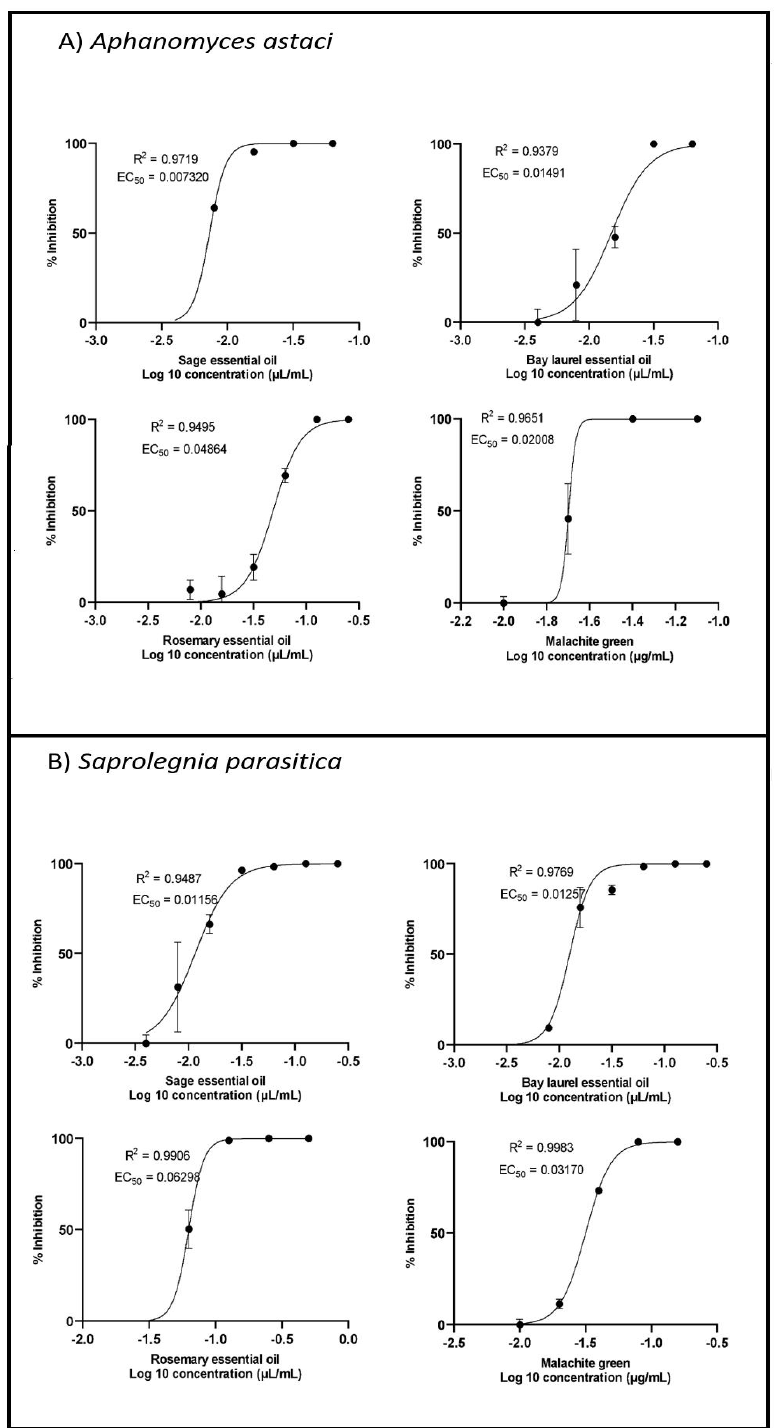
Figure 3. Zoospore germination inhibition curves of A. astaci and S. parasitica treated with sage, bay laurel, and rosemary essential oils. Mean values ± standard error (n = 3) are presented.